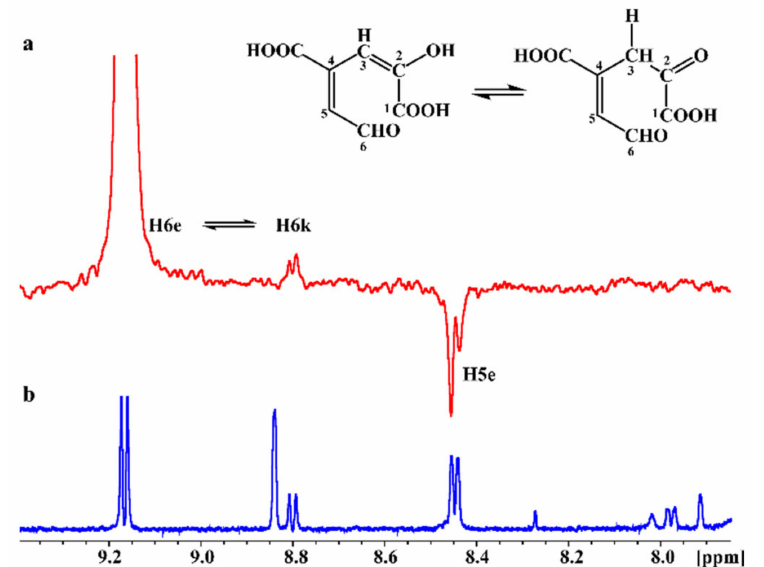
Figure 5. ( a ) STD NMR spectrum of the enzymatic biotransformation of PCA by 4,5-dioxygenase to the reaction product, CHMS, inside the NMR tube. Irradiation was applied selectively on the H6e proton resonance of the enol form. ( b ) 1 H NMR spectrum of the same